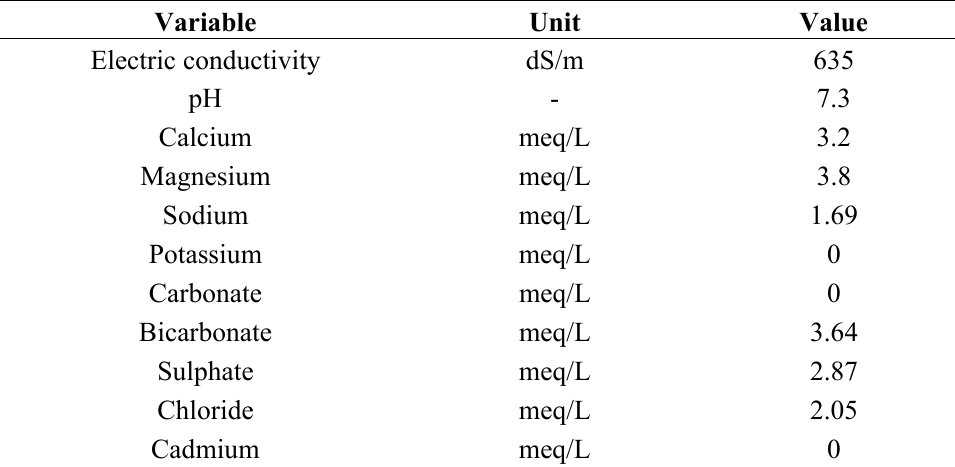
Table 4. Chemical configurations of Varamin Valley groundwater (meq/L, milliequivalent of solute per